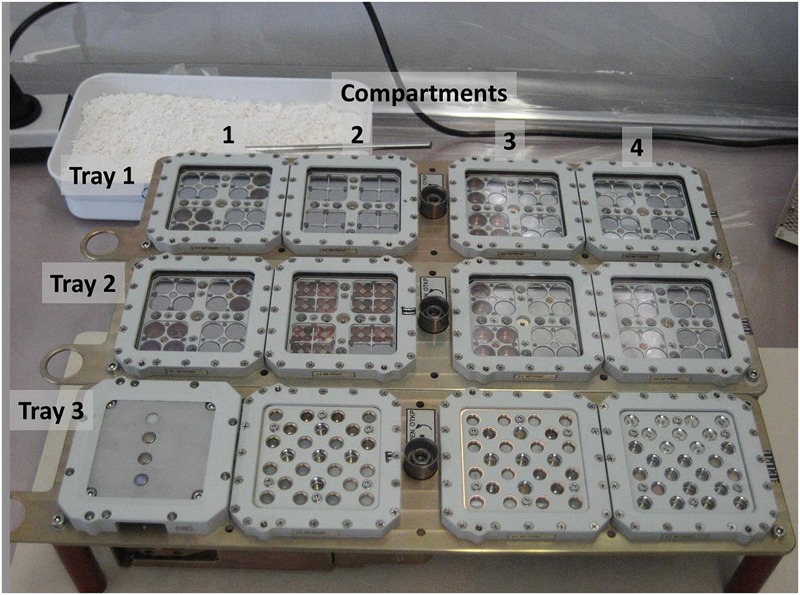
EXPOSE-R2 flight trays with all experiments integrated. Top to bottom: Trays 1, 2, 3; left to right: compartments 1, 2, 3, and 4. Valves and earrings are on the left side. Bottom left compartment with the active radiation measurement instrument R3D. The earrings were intended to secure the trays during EVAs. Credit: DLR.